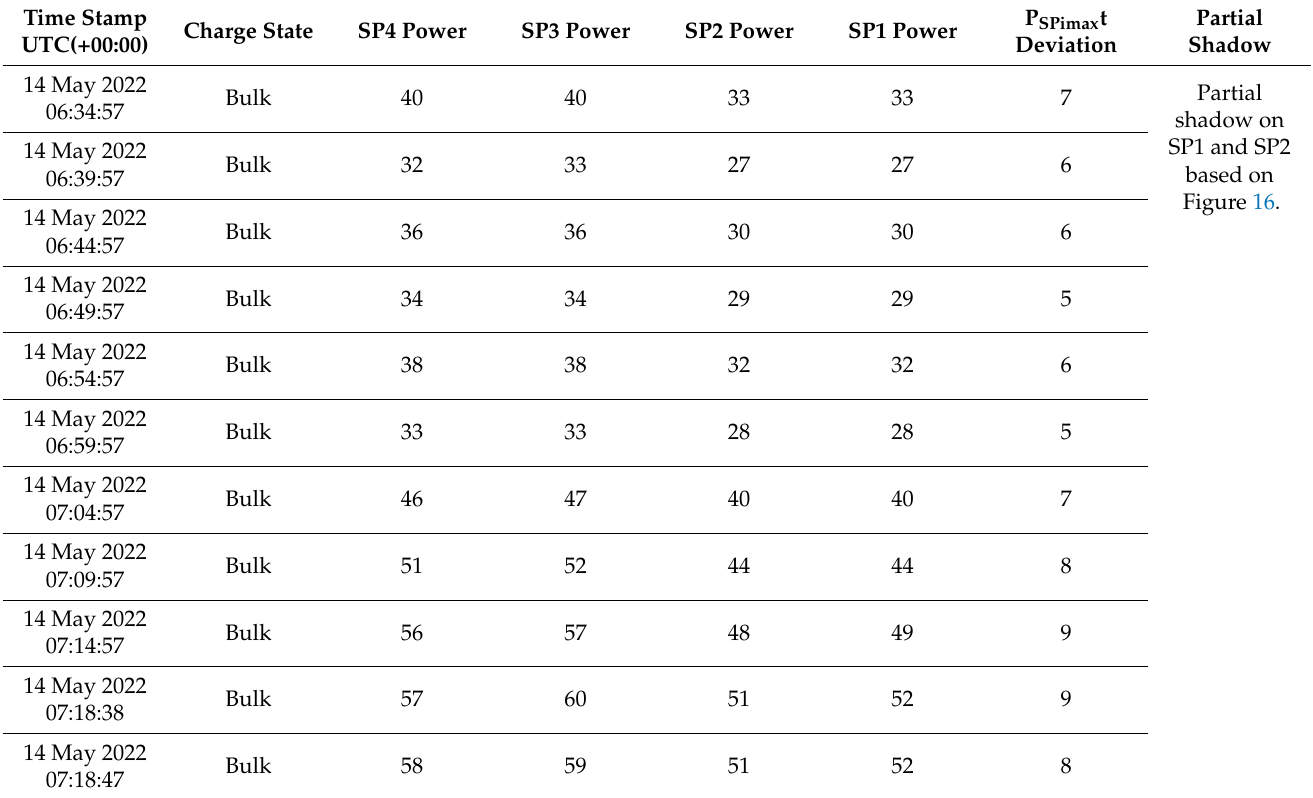
Table A1. SP quantitative power values and deviation registered the 14 May 2022 from 06:34:57